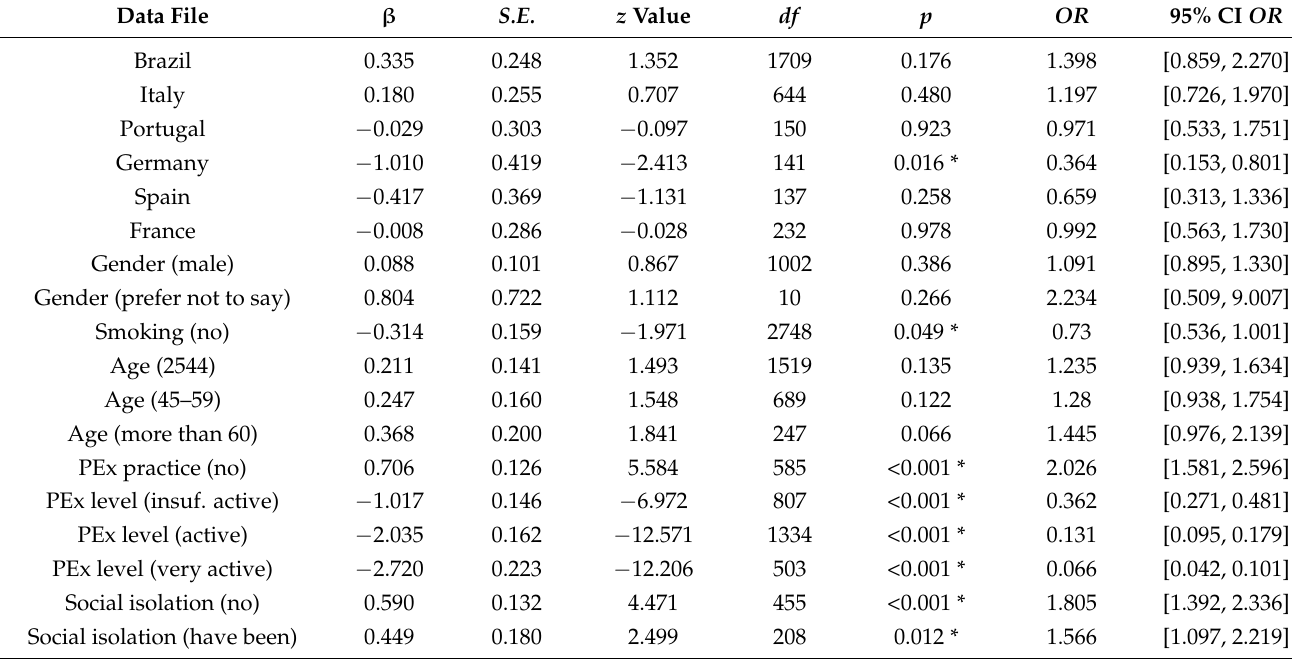
Table 5. Results of the multivariate logistic regression for the nonpractice of PEx during the quarantine period for the overall sample ( n =